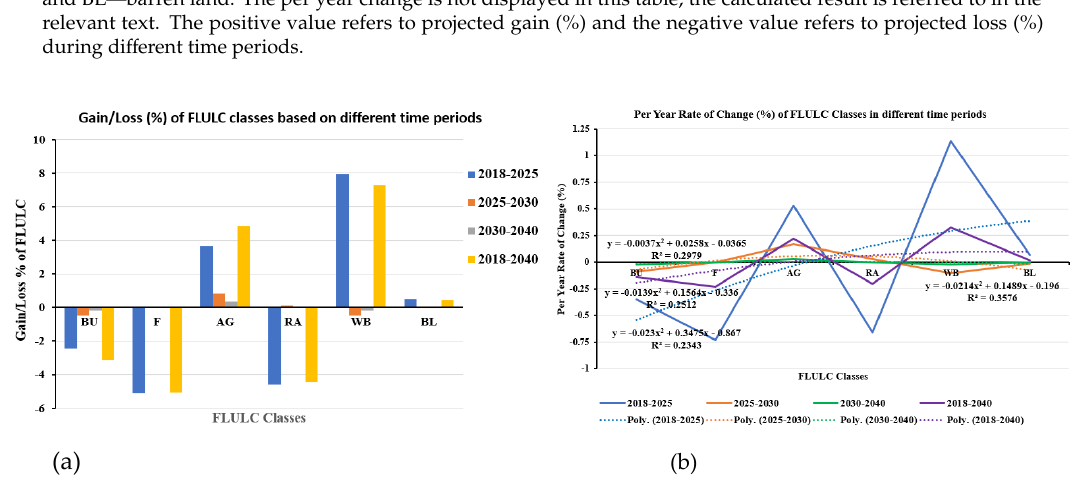
Figure 8. FLULCC distribution of the study area in four different time periods; (a) gain/loss (%) of each FLULC class; (b) per-year rate of change (%) of FLULC classes. Note: BU—built-up area; F—